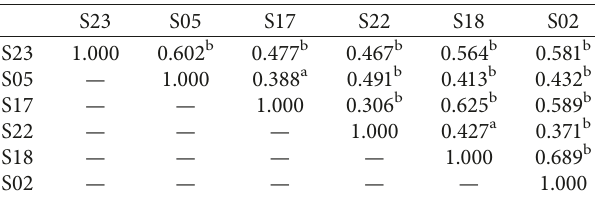
Table 5: Pearson correlations for component